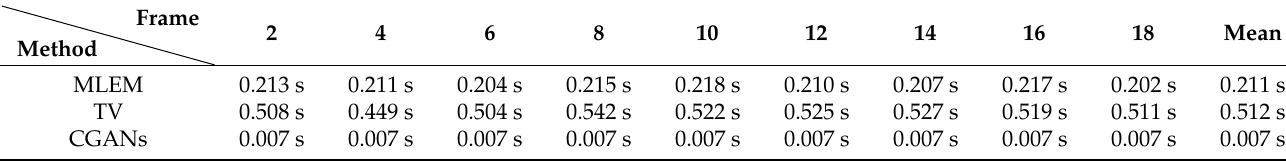
Table 3. Reconstruction times for Zubal thorax.